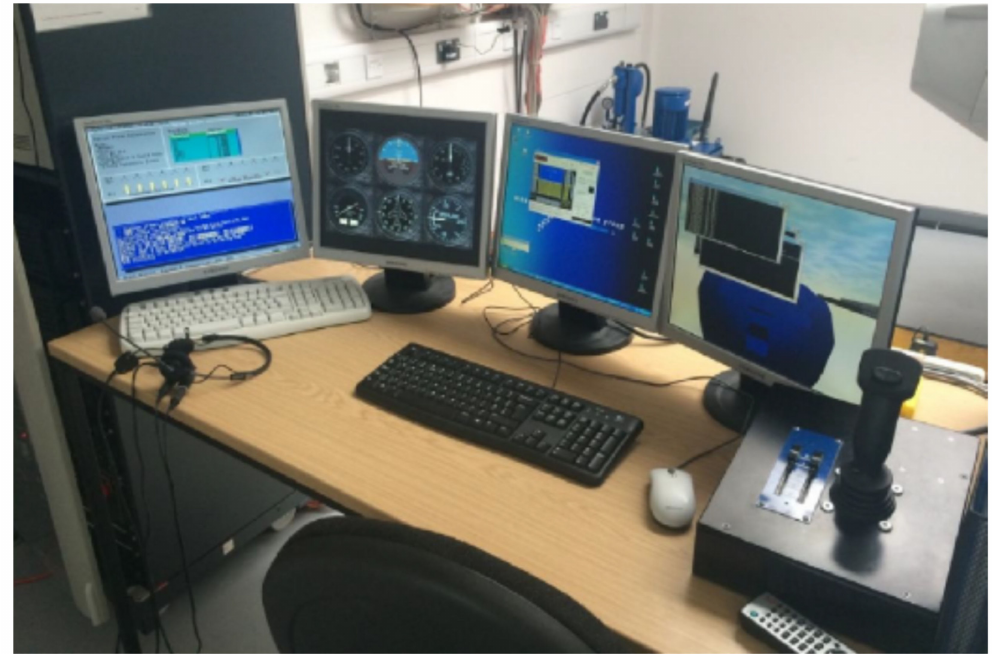
Figure 7. Engineering flight simulator instructor